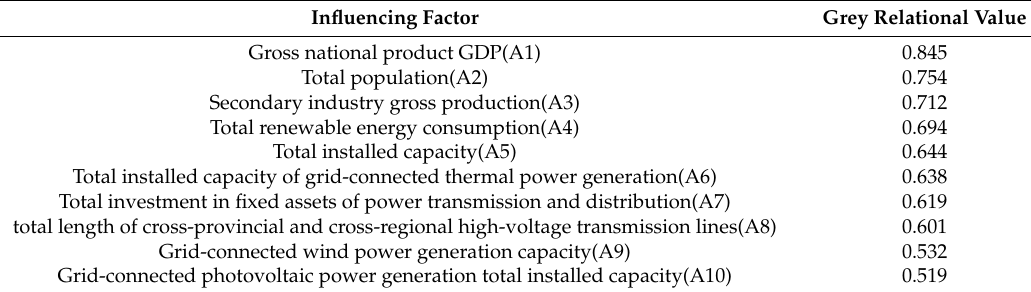
Table 1. Factors affecting renewable energy terminal power